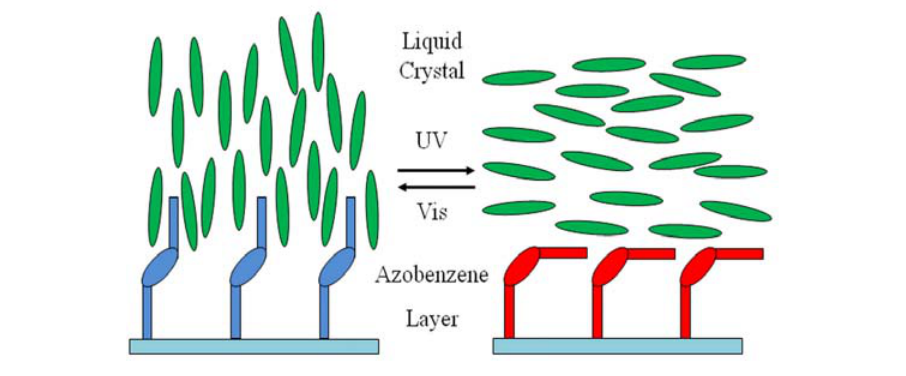
Figure 4. Photo-controlled alignment in liquid